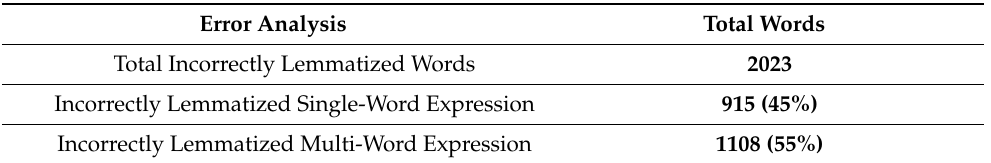
Table 9. Error analysis of the without-PoS-DLA approach with respect to single-word and multi-word expressions.